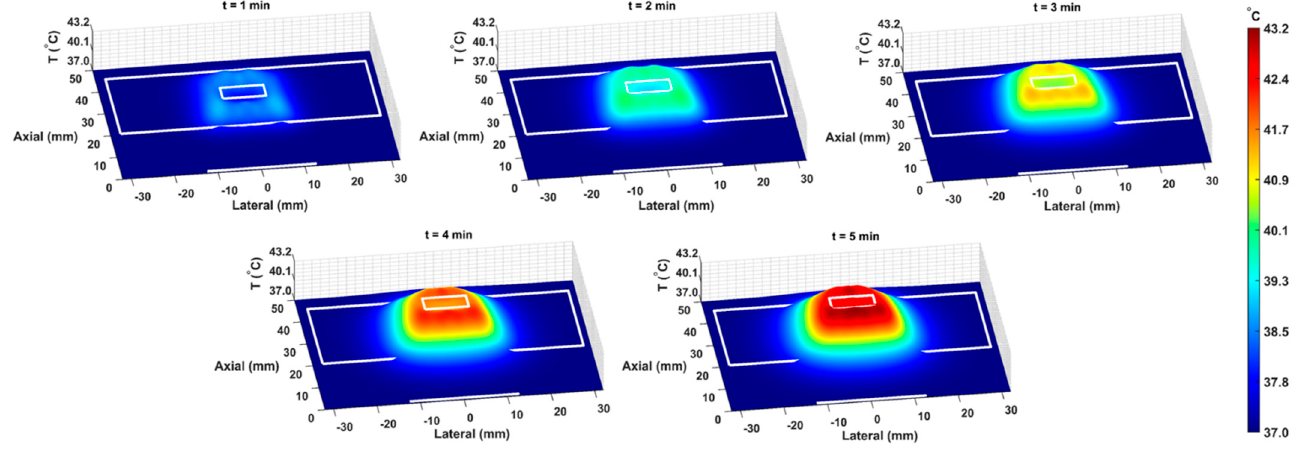
Figure 5. The spatiotemporal thermal field, due to LIPUS heating for the 5-minute LIPUS exposure at 1-minute intervals. White lines indicate the LIPUS transducer, porcine tissue domain, and GNP chamber domain. A height expression was added to the 2D thermal field to show the temperature distribution around the GNP chamber and throughout the tissue sample on the z -axis.